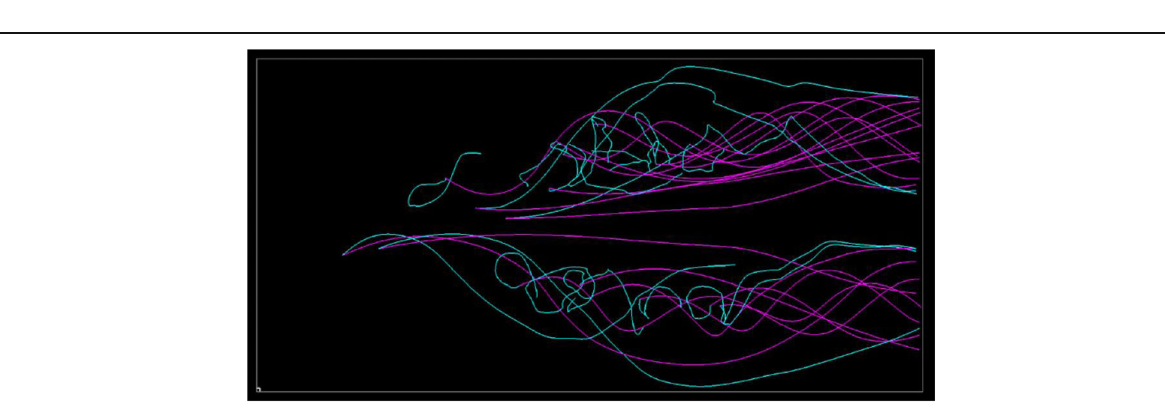
Fig. 8 Visualization from another viewpoint. (20 and 33 degrees of the angles of